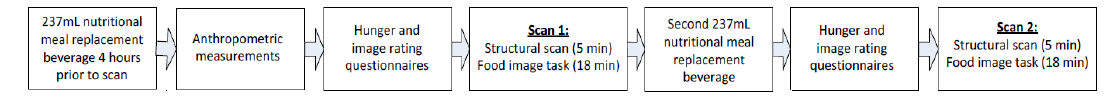
Figure 1. Flow diagram of the study